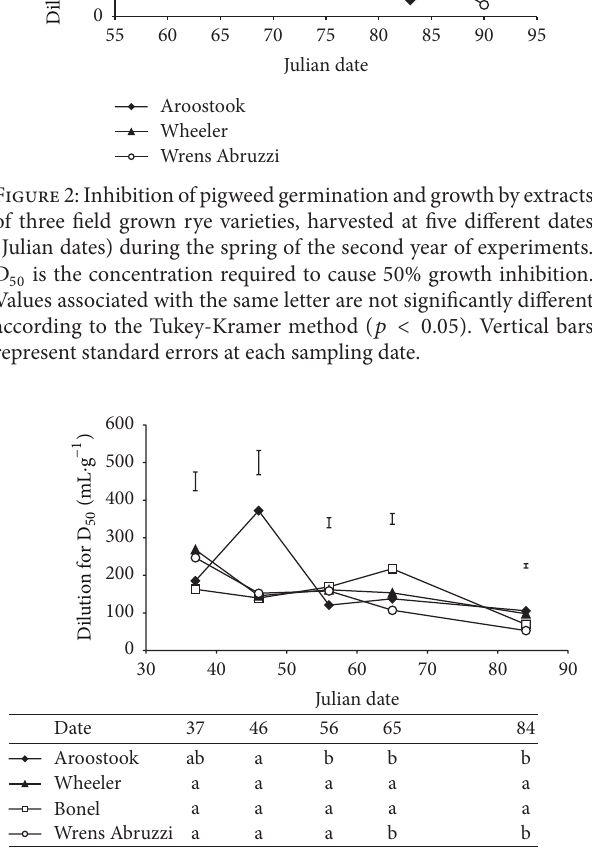
Figure 3: Inhibition of ryegrass germination and growth by extracts of four field grown rye varieties, harvested at different dates (Julian dates) during the spring of the first year of experiments. D 50 is the concentration required to cause 50% growth inhibition. Significant differences over time within each variety according to the Tukey- Kramer method ( 𝑝 < 0.05 ) are indicated by different letters. Vertical bars represent standard errors at each sampling date.